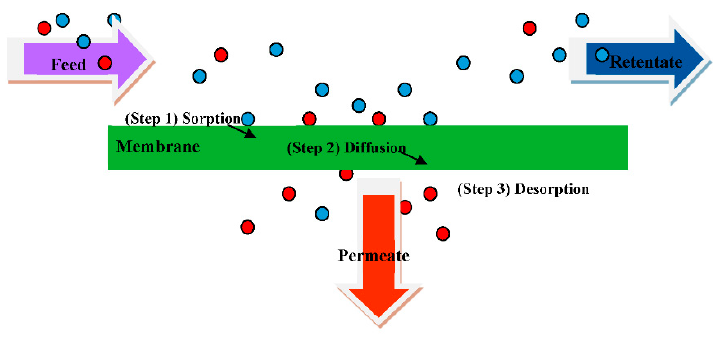
Figure 1. Schematic representation of solution-diffusion mechanism through a membrane.